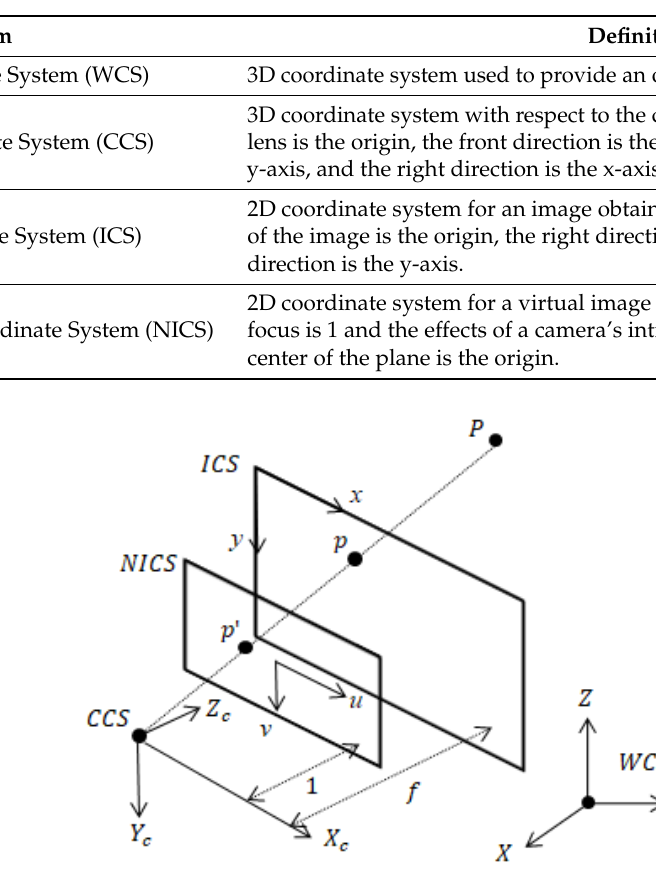
Figure 2. Coordinate